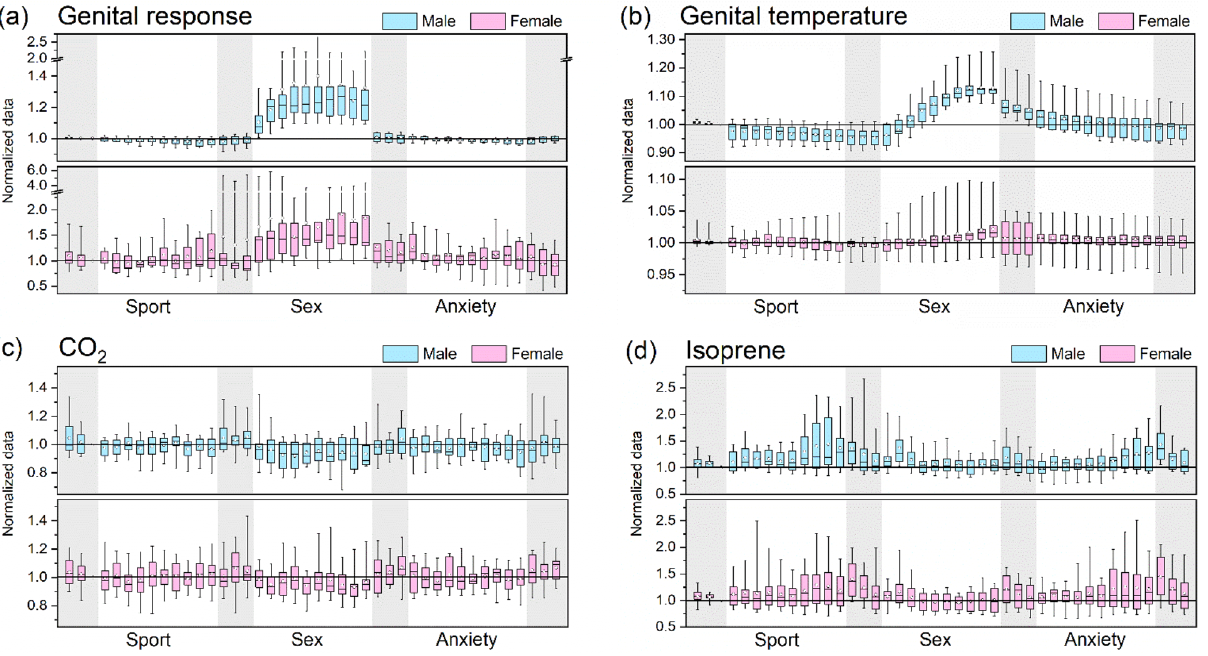
Figure 2. ( a ) genital response (male: penile circumference; female: vaginal pulse amplitude) ( b ) genital temperature (male: glans of the penis; female: clitoris) ( c ) exhaled breath CO 2 and ( d ) isoprene in breath for male (in blue) and female (in pink) participants during each minute of different film clips. Data were normalized to the 3rd minute of the first neutral clip based on measured raw signals. Shaded area represents the time when neural clips were played. The boxes represent 25% to 75% of the dataset, with the circle and central line indicting the mean and median values, respectively. The whiskers indicate the minimum and maximum data points. The horizontal solid line in each sub-plot represents the value at 1.0 as a